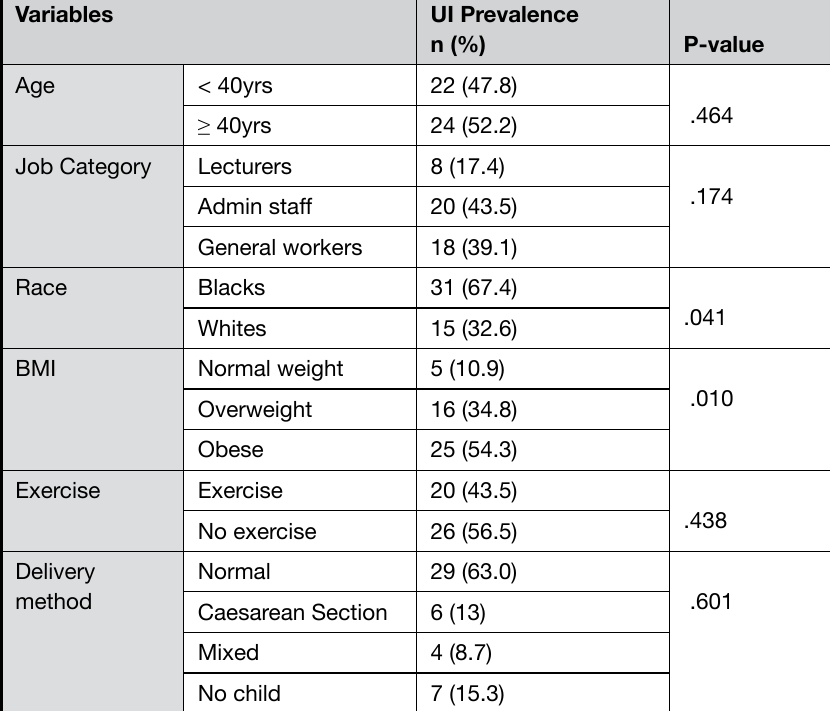
Table 3: cross-tabulation between variables and ui Prevalence (n = 46) variables